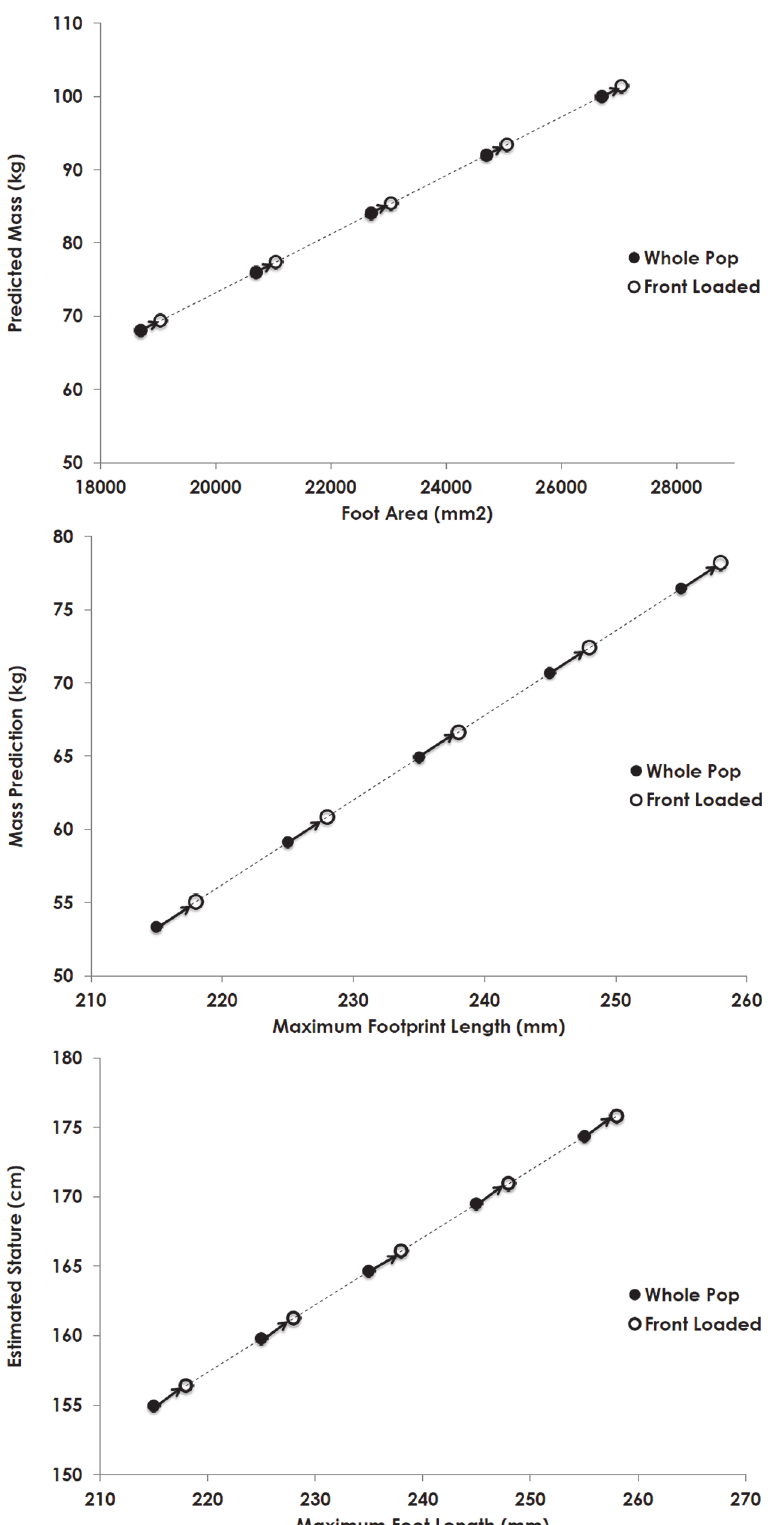
Fig 6. Showing the regression equations for maximum foot length and foot area predicting either mass or stature. Following the arrows from each point illustrates the overestimation of mass from footprints of loaded individuals, as determined by the mean percent